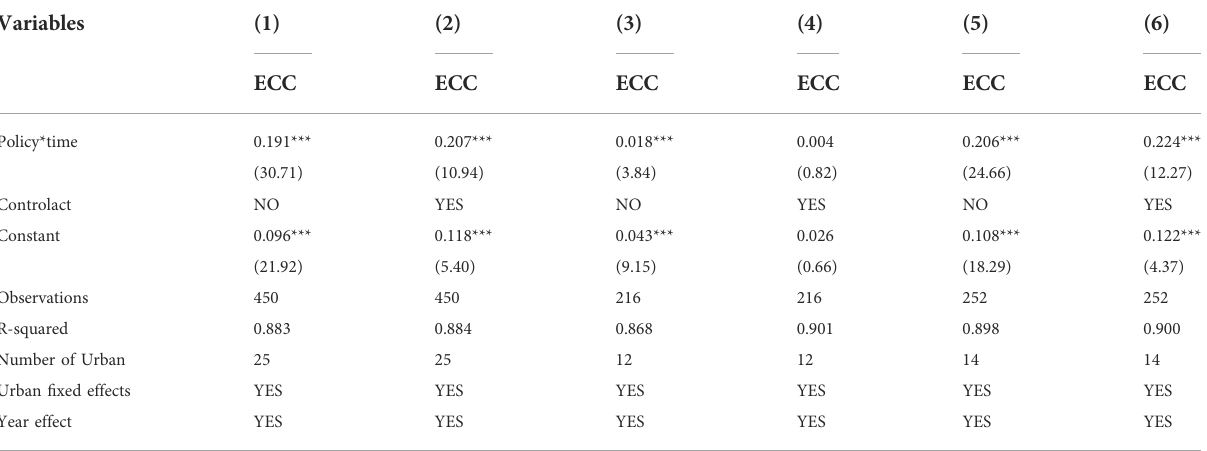
TABLE 3 Heterogeneity analysis table.